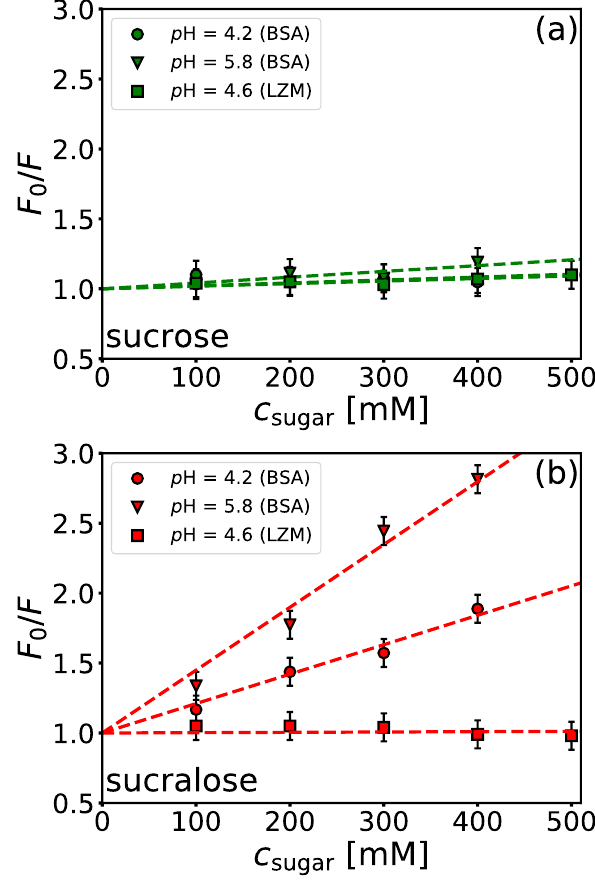
Figure 7. Sucralose interacts with hydrophobic pockets of BSA. Stern-Volmer plots for the quenching of BSA and lysozyme (LZM) by ( a ) sucrose and ( b ) sucralose. The concentration of BSA and LZM was 0.5 and 2 µ M, respectively ( λ ex = 280 nm, T = 25 °C). All solutions were prepared in acetate buffers of different p H-values but with the same ionic strength ( I = 0.1